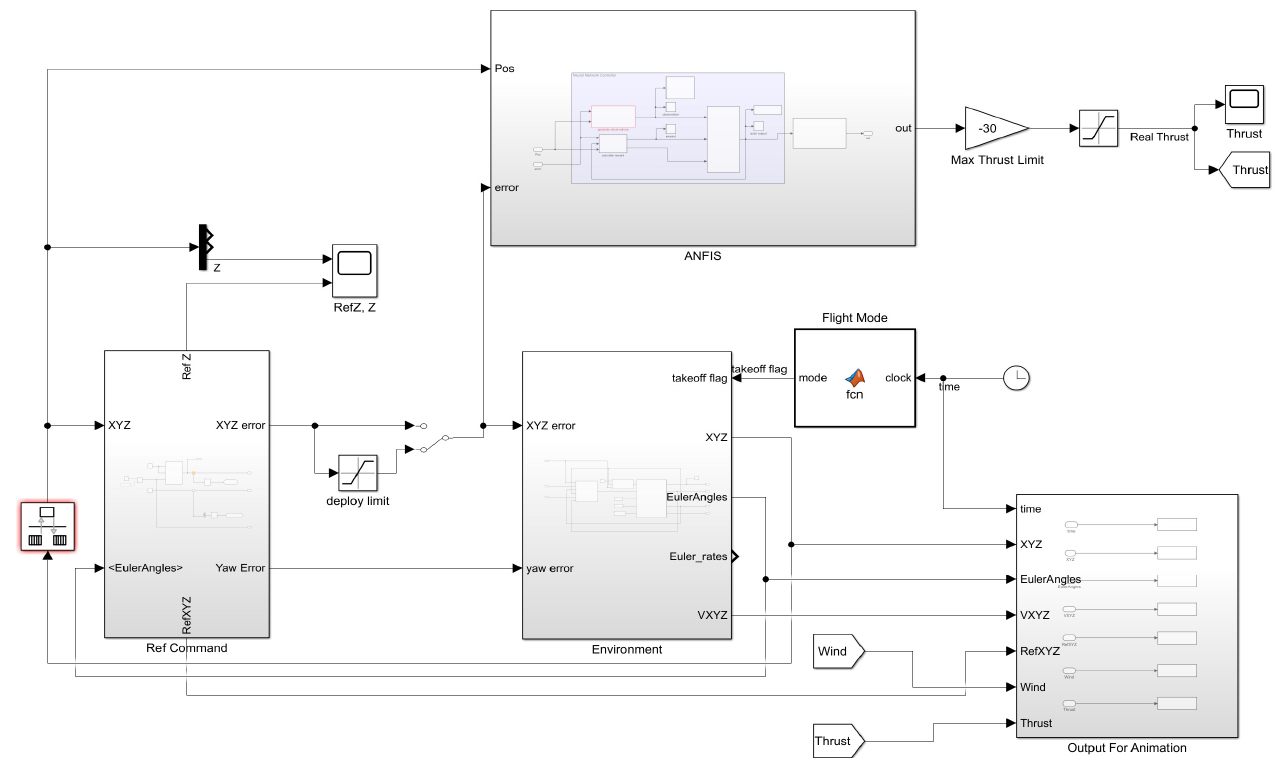
Figure 15. Model of Neural network–Fuzzy controller for marine rescue drone in Matlab/Simulink.